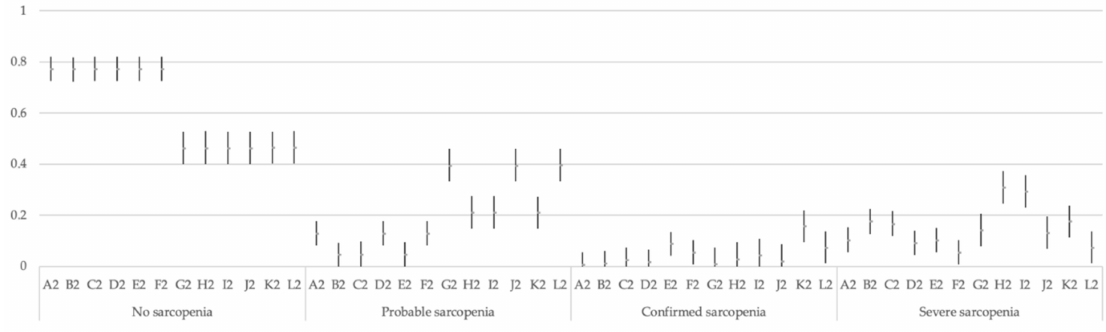
Figure 2. Multinomial 95% confidence intervals for the proportion of each category in the 12 options of Model 2.